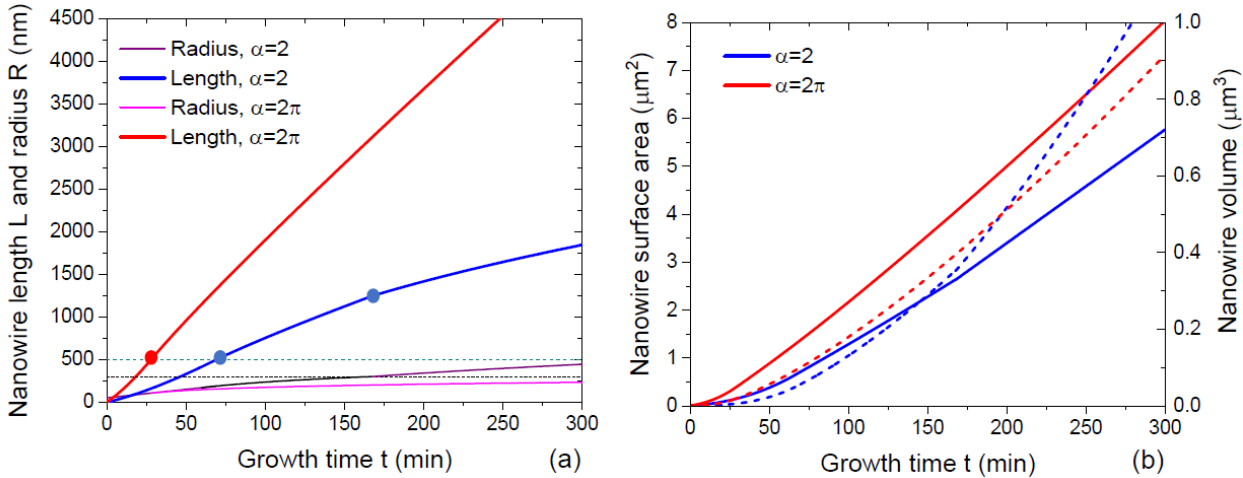
Figure 4. Morphological evolution of NWs in terms of ( a ) length and radius, and ( b ) total surface area and volume, for two different α of 2 and 2 π . Horizontal dashed lines in ( a ) correspond to the length L 1 = 500 nm, at which the growth is transitioned from stage 1 to stage 2, and to the radius R 2 = 300 nm, at which stage 3 starts. Solid and dashed lines in ( b ) show the NW surface areas and volumes, respectively. Circles in ( a ) show the transitions from stage 1 to stage 2 and from stage 2 to stage 3 at α = 2. The NW length at α = 2 π is systematically larger, and the radius is systematically lower than at α = 2. The length evolution is super-linear in stage 1, slightly sub-linear in stage 2, and markedly sublinear in stage 3. The time evolution of the NW surface area becomes almost linear in the large time limit. The NW volume increases super-linearly with time in all stages. The NW at α = 2 is shorter and thicker than at α = 2 π , which is why the NW volumes are similar. In the large time limit, the NW volume increases even faster at α = 2.